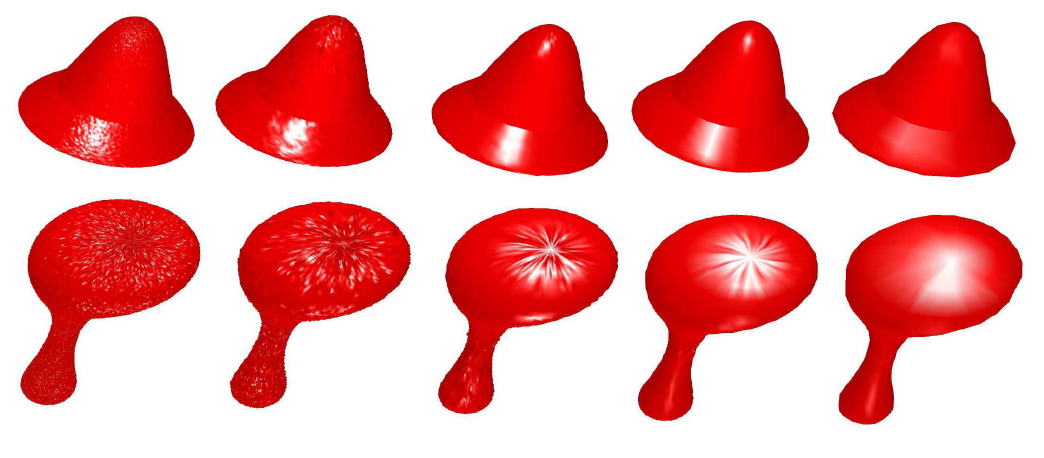
Figure 9. Progressive wavelet analysis of surfaces (with white noises) from level 4 to level 0.